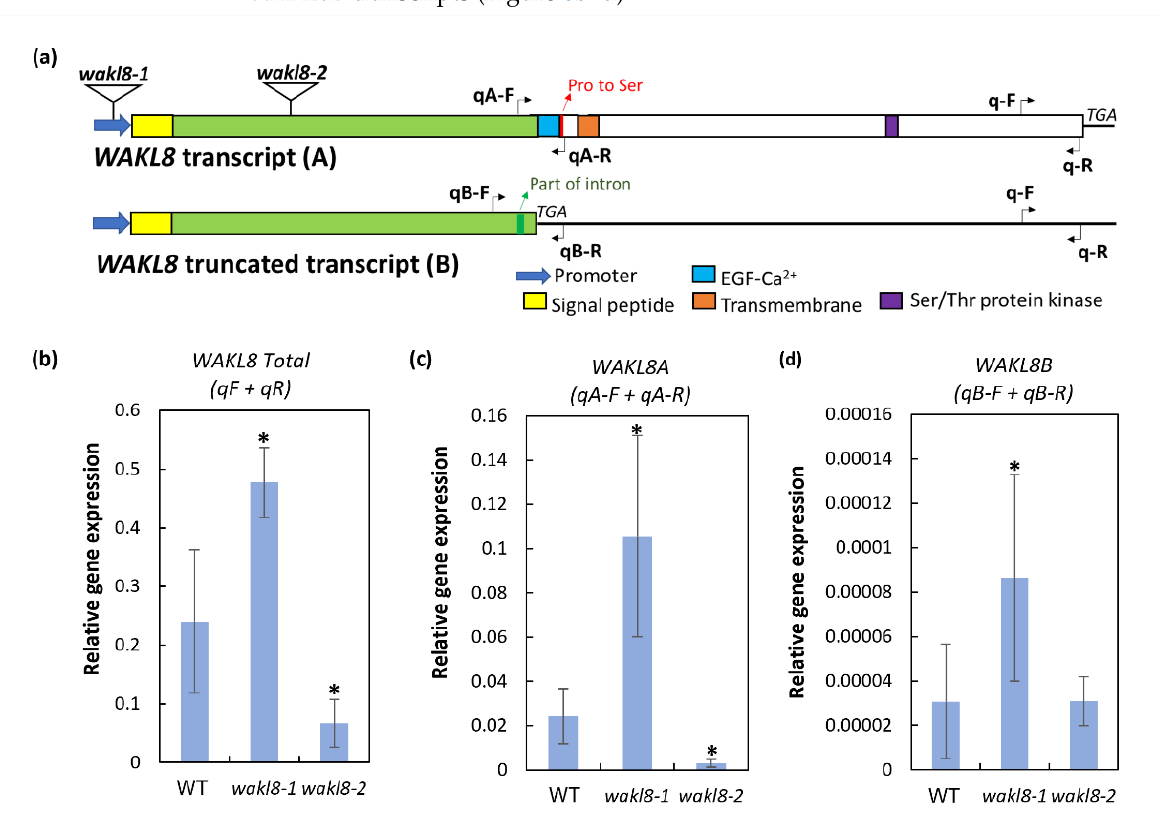
Figure 6. Schematic representation of WAKL8 alternative spliced transcripts and Q-PCR analysis of transcript levels. ( a ) The WAKL8A transcript encodes a predicted protein with an N-terminal signal peptide (yellow), followed by an extracellular putative polysaccharide-interacting domain (green), EGF-Ca 2+ domain (blue), transmembrane domain (orange), and cytoplasmic kinase domain (purple). The WAKL8B transcript has part of the first intron retained (red) and introduces a stop codon before the predicted EGF-Ca 2+ domain. Positions are shown of T-DNA insertion in WAKL8 to give wakl8-1 and wakl8-2 mutants and sites of primers used for Q-PCR analysis. ( b ) qPCR analyses of all WAKL8 transcripts, ( c ) WAKL8A transcripts, and ( d ) WAKL8B transcripts in WT, wakl8-1 , and wakl8-2 mutant plants. Data shown as average ± SD acquired from 3 biological replicates. * Significant difference compared with WT plants, p < 0.05 using Student’s t -test.